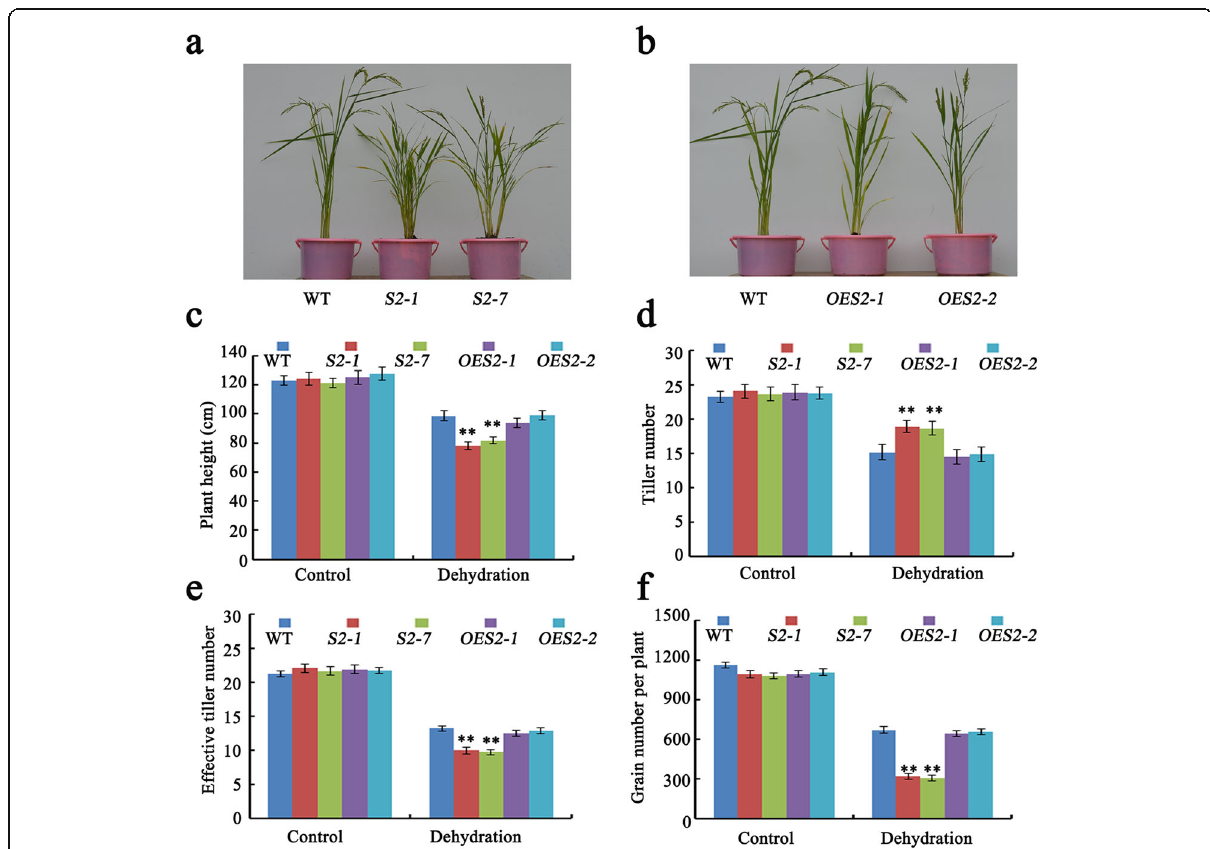
Fig. 1 SAPK2 has large effects on plant height and grain number under RDS for 30 days. a Phenotypes analysis of WT and sapk2 mutant lines at mature stage under RDS. b Phenotypes analysis of WT and OE lines at mature stage under RDS. c-f Comparison of agronomic traits including plant height (c), tiller number (d), effective tiller number ( e ), grain number per plant ( f ) among WT, sapk2 mutant lines and OE lines under RDS. Data in c-f are shown as means ± SD ( n = 20) from three replicates. A student ’ s t -test was used to generate P values; “ ** ” indicate significance at P <